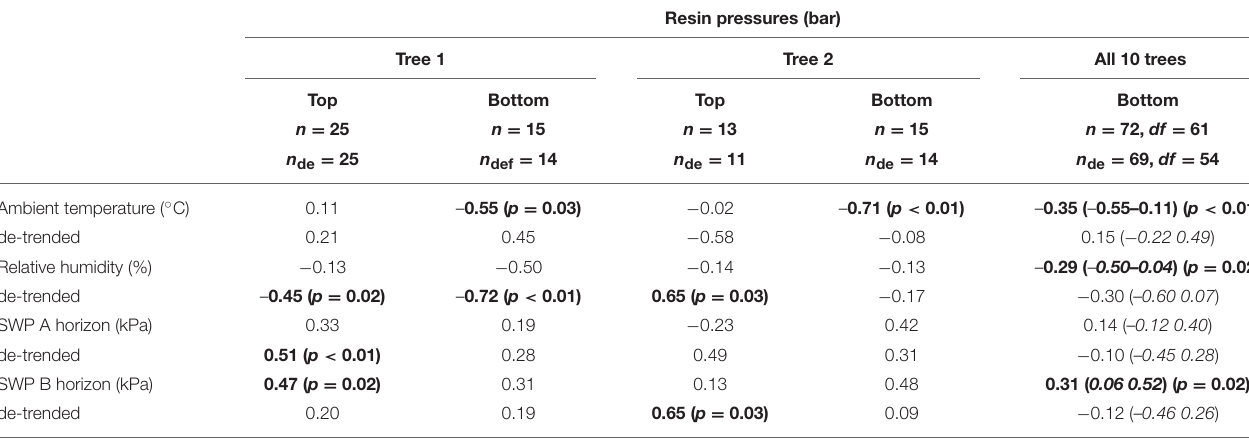
TABLE 3 | Pearson’s correlation coefficients between three-day averages of resin pressure (Trees 1 and 2, top and bottom part of stem) and repeated measures correlations (Rmcorr) over the ten measured trees (bottom parts), and ambient temperature, relative humidity and soil water potentials (SWP).